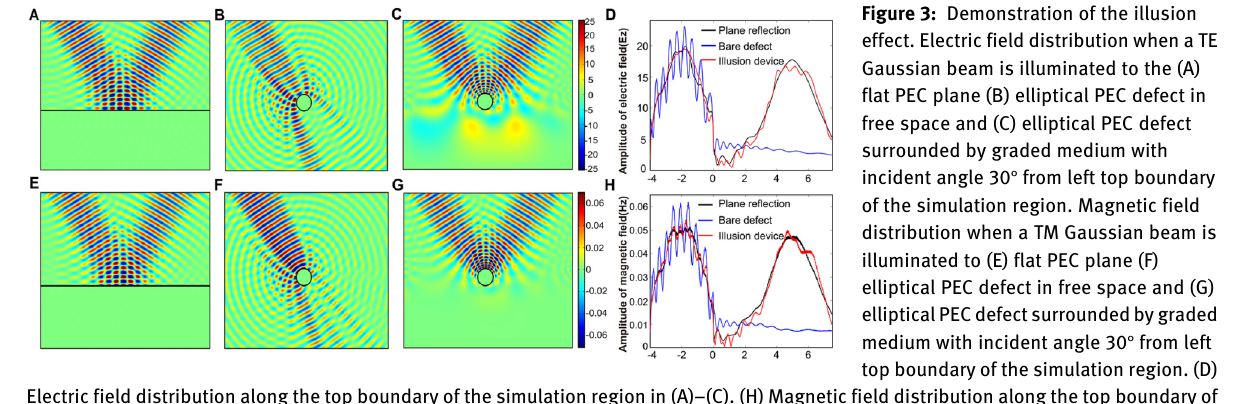
electric fi eld magnitudes along the top boundary of the simulated region in the cases of plane re fl ection, the bare PEC ellipse, and PEC ellipse surrounded by the illusion device are compared and denoted by black, blue and red curves, respectively, in Figure 3D. In two dimension sen- ario, the electromagnetic fi eld can be decoupled into TE (Electric fi eld along out of plane direction) and TM (Mag- netic fi eld along out of plane direction) waves. Thus, in order to demonstrate that this illusion device is polariza- tion independent, we consider both TE (sub Figure A – D) and TM (E – H) polarized incident waves. To explore the